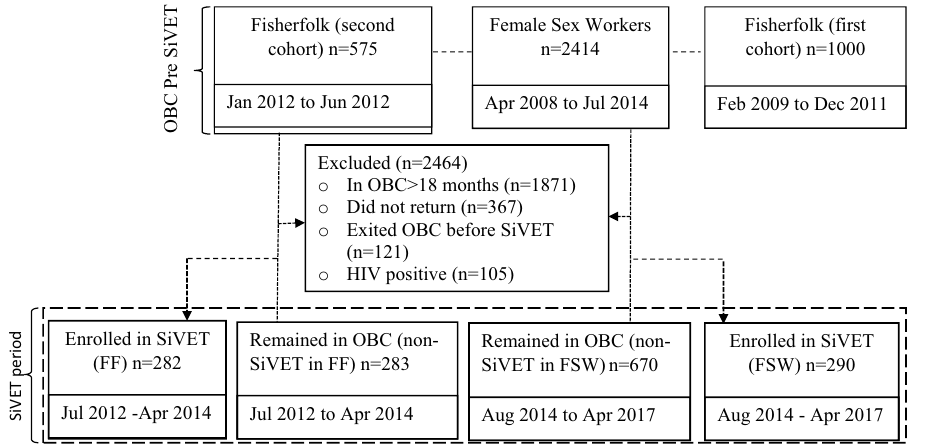
Figure 1. Flow of participants from the observational cohorts to SiVET in pre-SiVET and SiVET concurrent